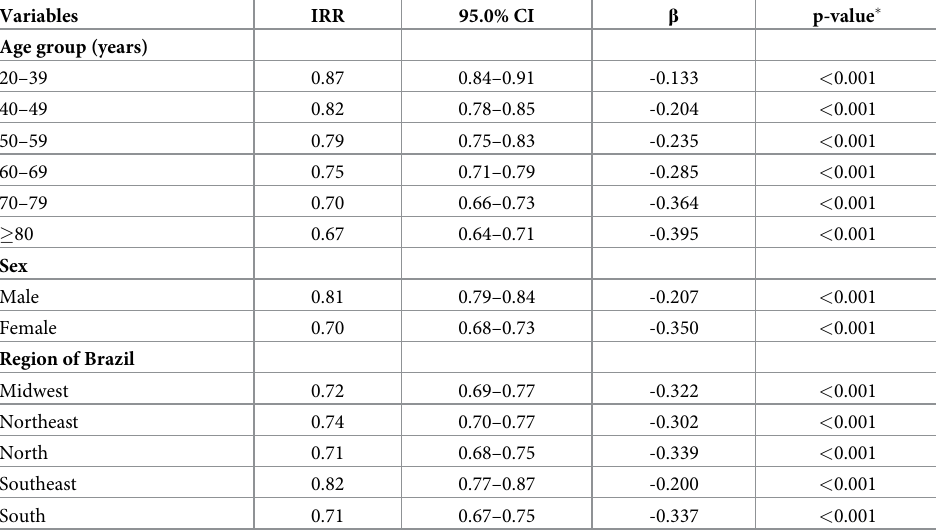
Table 8. Poisson multiple regression models of the impact of the coronavirus disease pandemic on the hospitali- zation rate for diabetes mellitus in Brazil according to subgroups by age group, sex, and region of Brazil.